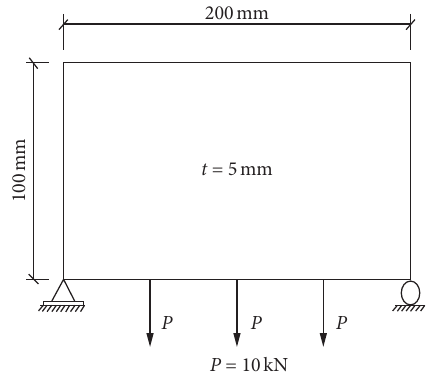
Figure 4: Simply supported beam under three concentrated loads.